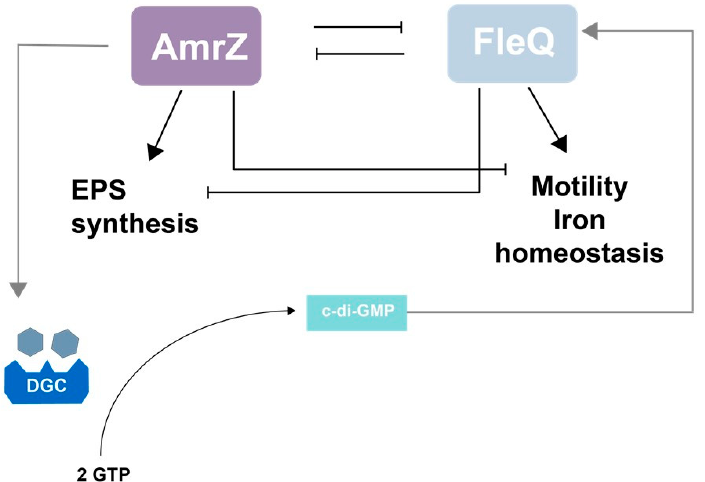
Figure 5. AmrZ and FleQ form a central hub for environmental adaption in Pseudomonas ogarae F113. Proposed model of the AmrZ and FleQ interplay in the regulation of traits implicated in environmental adaption. According to this model, AmrZ and FleQ form an oscillator by their mutual transcriptional repression. AmrZ activates EPSs production genes and represses motility and iron homeostasis genes. Conversely, FleQ acts as an activator of motility and expression of iron homeostasis genes and as a repressor of EPSs genes. The second messenger c-di-GMP participates in this circuit since AmrZ activates the expression of diguanylate cyclases and FleQ transcriptional regulation is modulated by c-di-GMP binding.